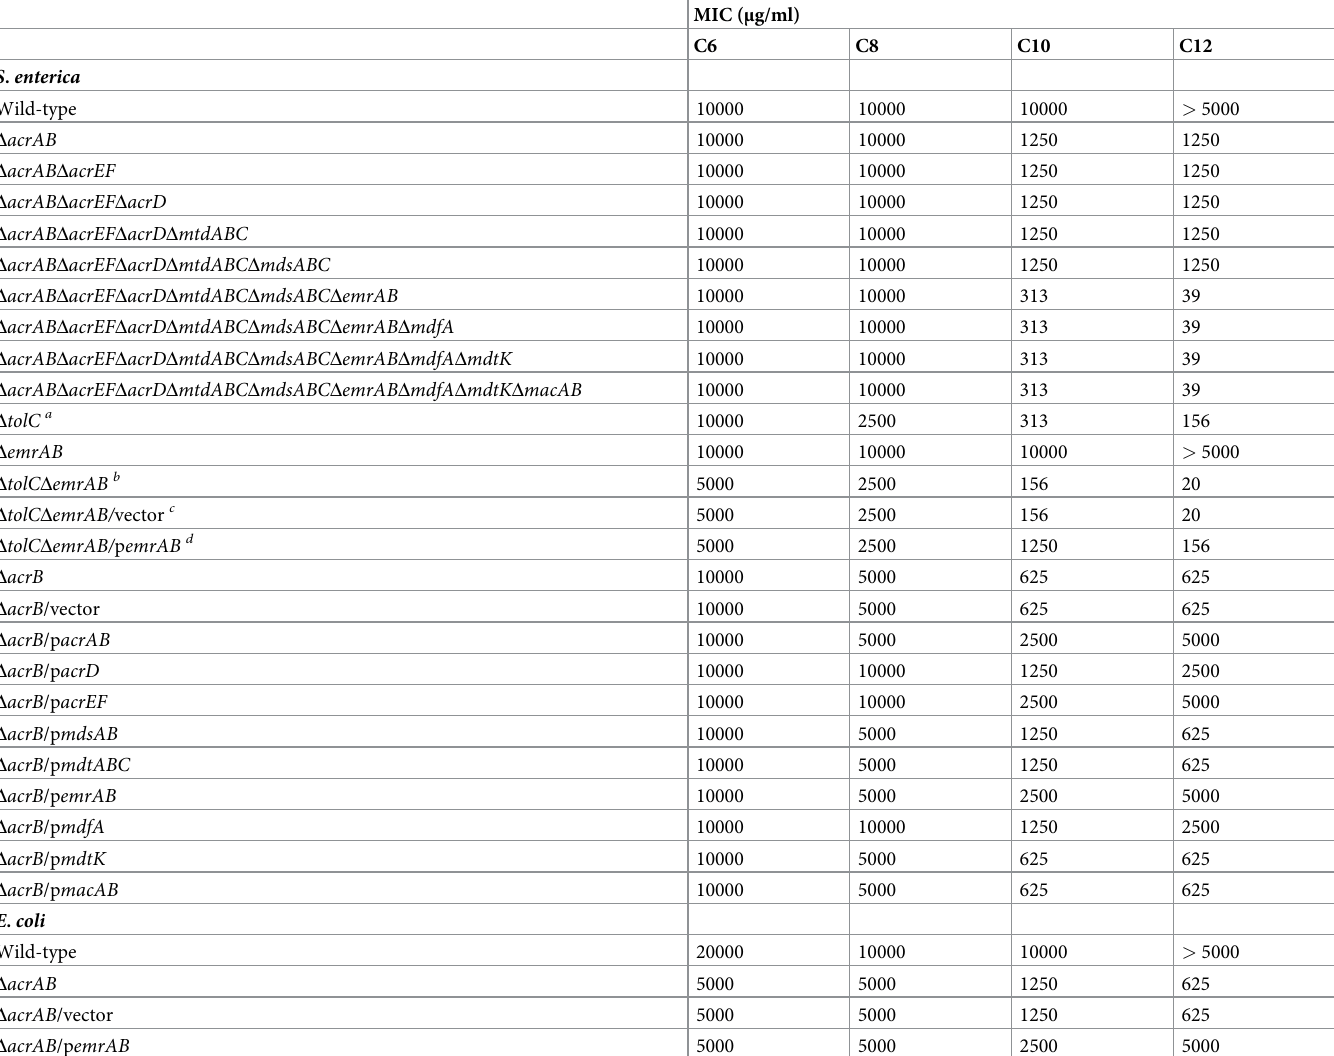
Table 2. Susceptibility of S . enterica and E . coli strains to sodium hexanoate (C6), sodium octanoate (C8), sodium decanoate (C10) and sodium dodecanoate (C12).